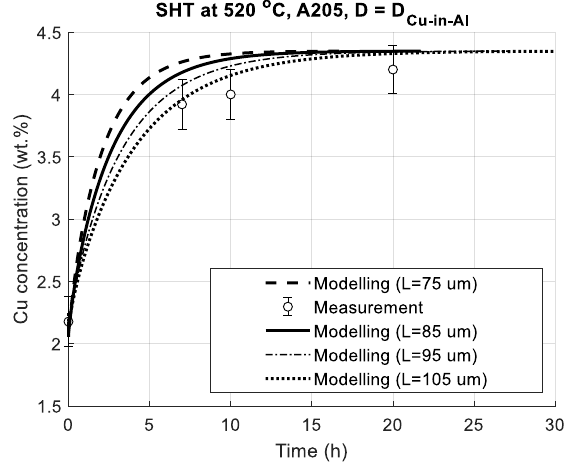
Figure 12. The effect of parameter, L, variation on the simulated Cu concentration in the matrix during solution heat treatment at 520 °C for the A205 alloy, at the typical value of diffusion coefficient.